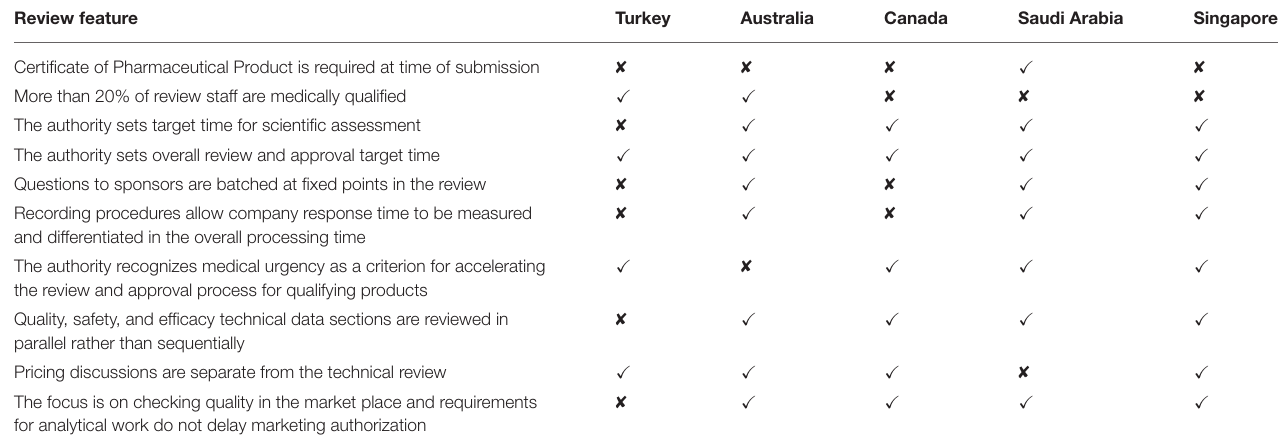
TABLE 6 | Key features of the five agencies’ review